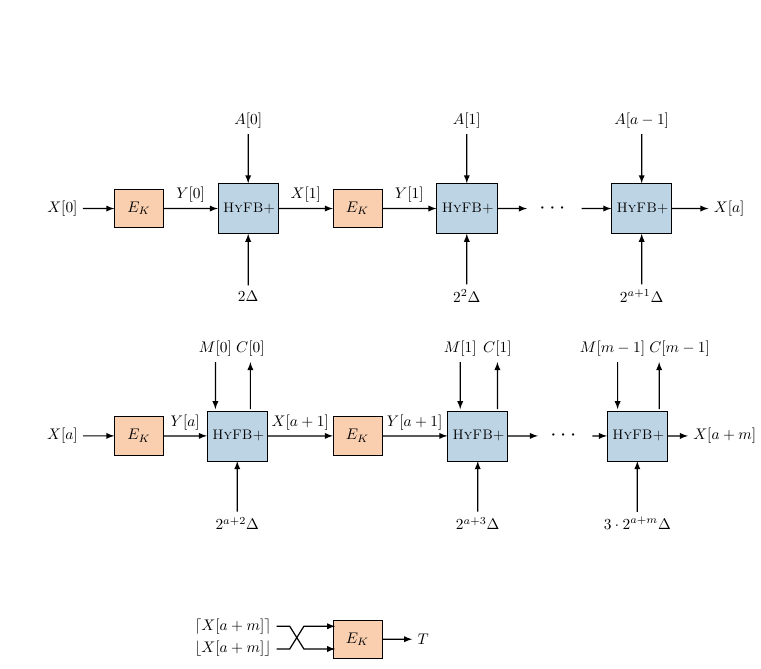
Figure 8: HyENA authenticated encryption mode for full data